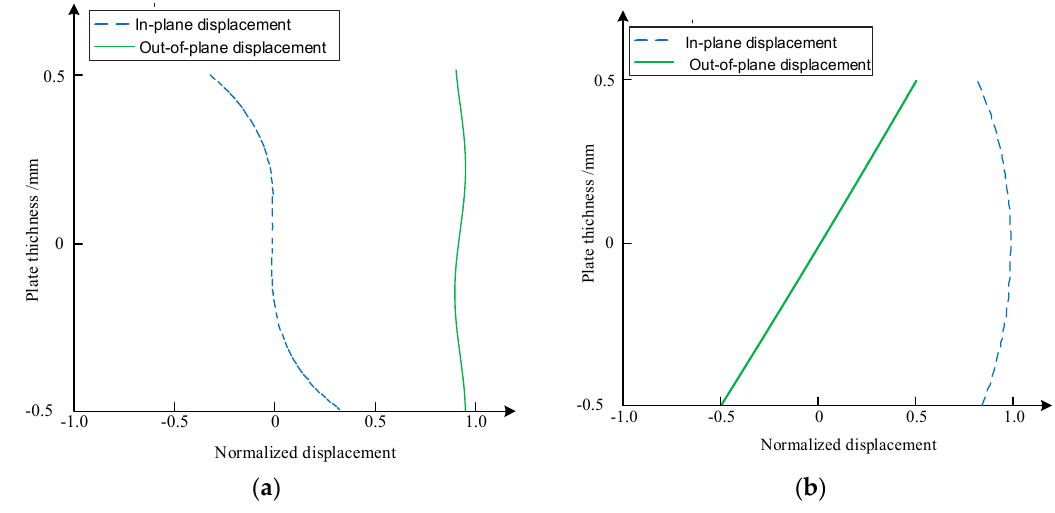
Figure 3. Particle displacement-amplitude curves of A 0 and S 0 modes in steel plate (( a ) A 0 mode; ( b ) S 0 mode).